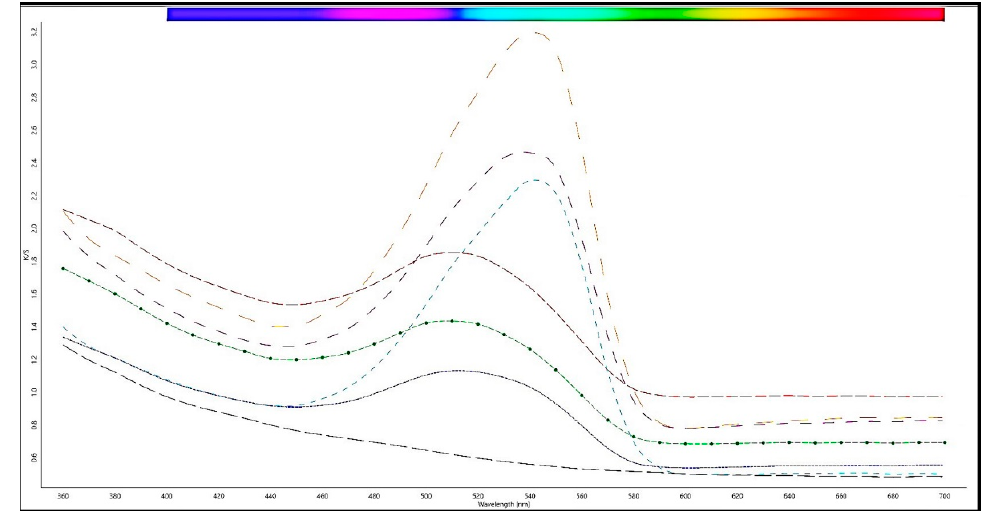
Figure 5. Representation of the measurement of surface color strength (K/S) versus wavelength in UV–Vis for MZH cement mortar.